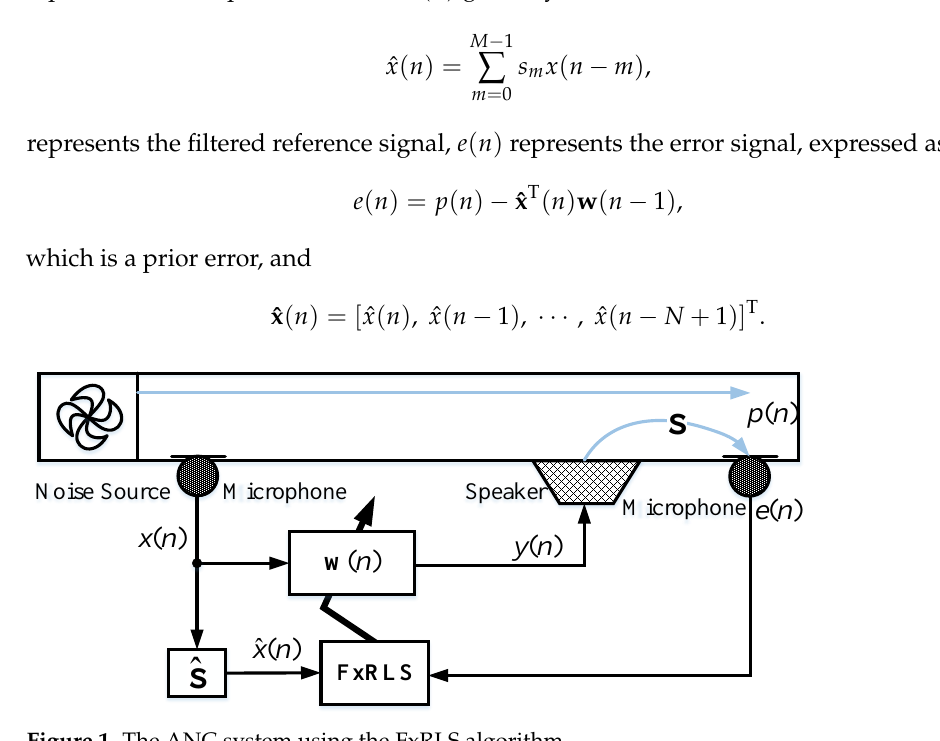
Figure 1. The ANC system using the FxRLS